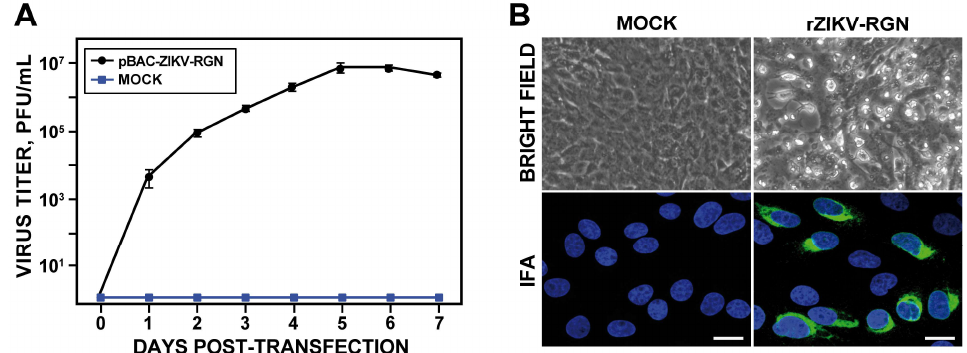
Figure 2. Recovery of infectious rZIKV-RGN from the BAC cDNA clone. ( A ) Virus rescue. Vero cells at 90% of confluence (6-well plate format; triplicates) were mock-transfected (Mock) or transfected with 4 µg/well of the ZIKV BAC cDNA clone (pBAC-ZIKV-RGN) and at the indicated times post- transfection, virus titers in the tissue culture supernatant of transfected cells were determined by plaque assay. Error bars represent standard deviations of the means from three experiments. ( B ) Analysis of the cytopathic effect (CPE) induction and ZIKV E protein expression. Vero cells were mock-infected (left) or infected (right) with 0.5 PFU/cell of the rescued virus (rZIKV-RGN) and at 48 h post-infection (hpi) analyzed for the induction of CPE by light microscopy (top) and for viral E protein expression by immunofluorescence assay (IFA) using the pan-flavivirus E protein mAb 4G2 (bottom). Bars, 20 µm.